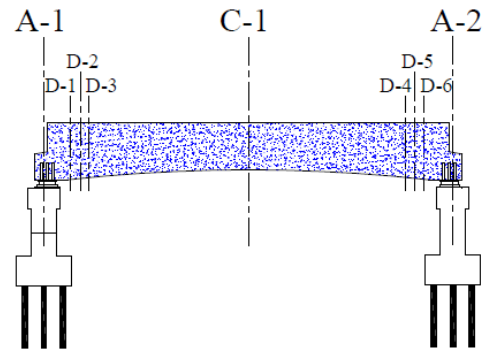
Figure 9. Details of locations for strain gauges (SP-2 and SP-3).